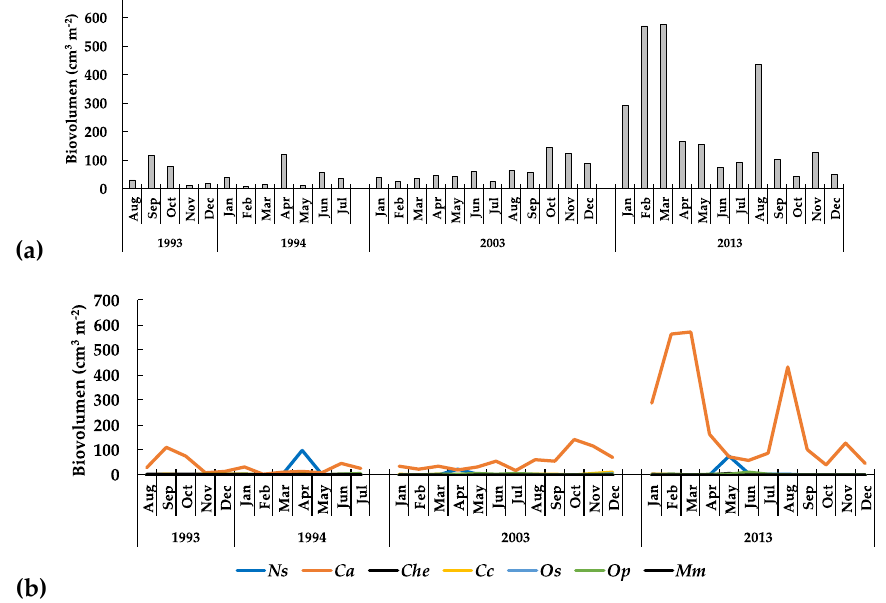
Figure 11. Temporal dynamics of ( a ) total phytoplankton and ( b ) per species biovolume in Lake Alchichica during 1993–1994, 2003, and 2013. ( Mm : Monoraphidium minutum , Op : Oocystis parva , Ns : Nodularia aff. spumigena , Cc : Cyclotella choctawhatcheeana , Os : Oocystis submarina , Che : Chaetoceros elmorei , Ca : Cyclotella alchichicana ).